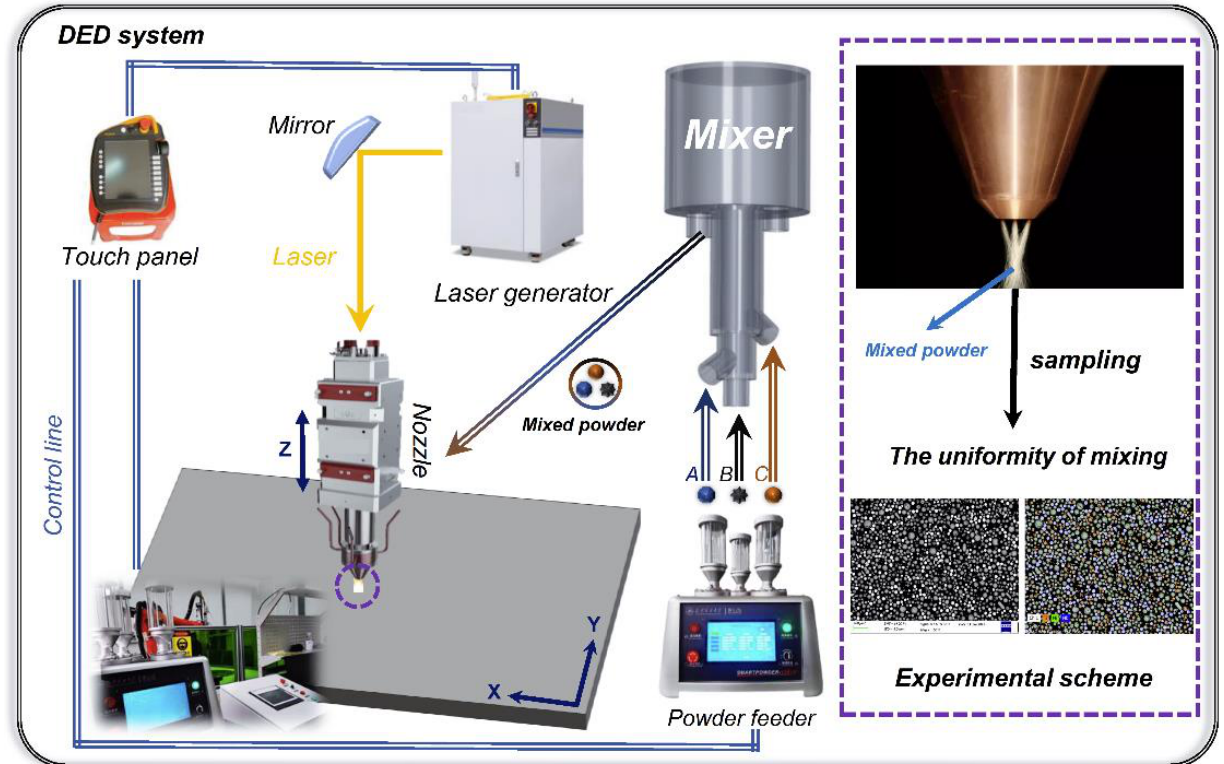
Figure 1. The novel DED principle and the experimental method.